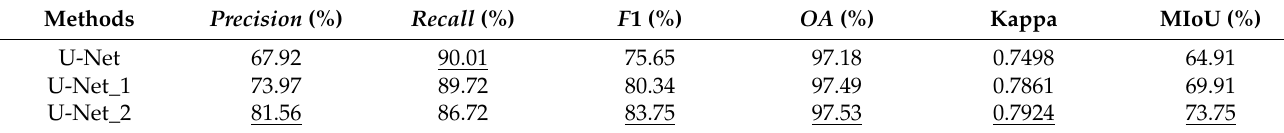
Table 2. Accuracy evaluation table of ablative analysis, the best value is